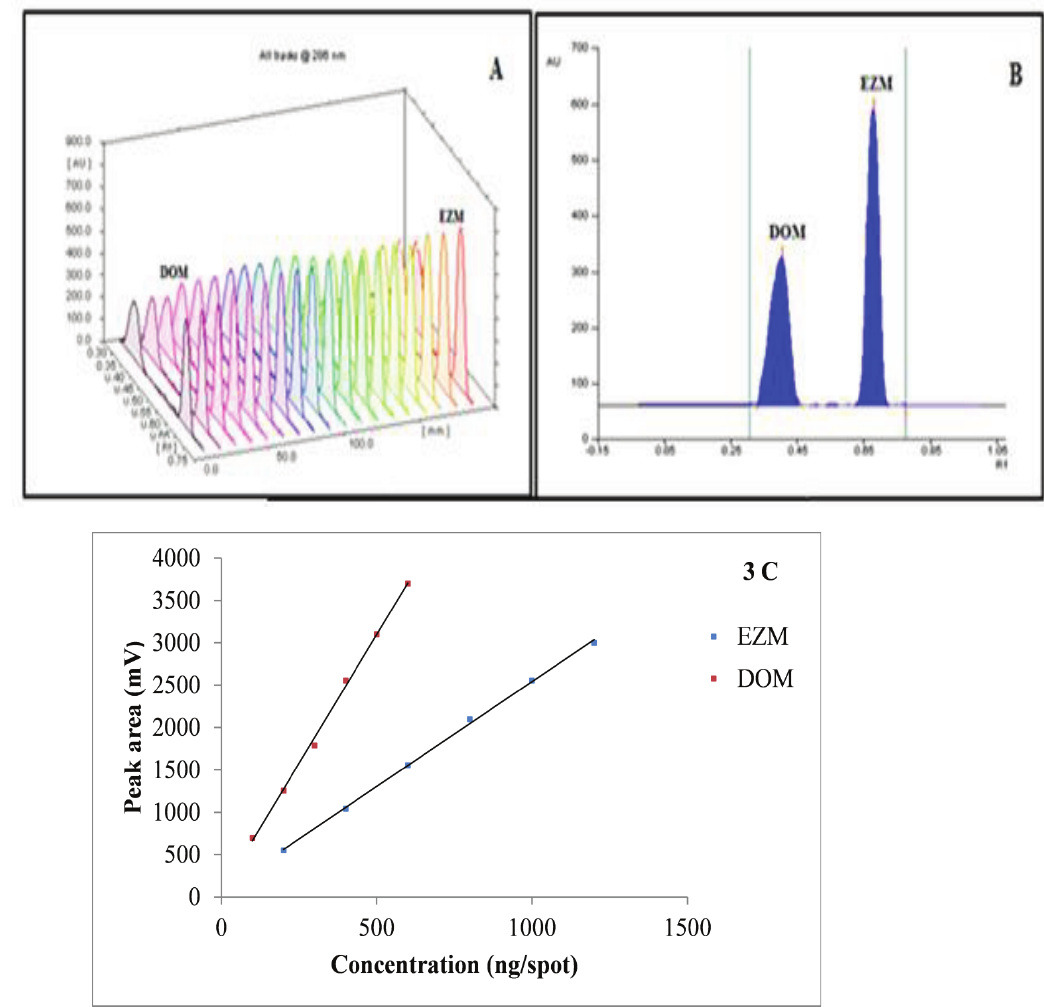
Figure 3: (A) Three dimensional chromatogram of EZM-DOM mixtures. (B) TLC chromatogram showing well separated peaks of EZM and DOM. (C) Calibration curves for EZM and DOM.